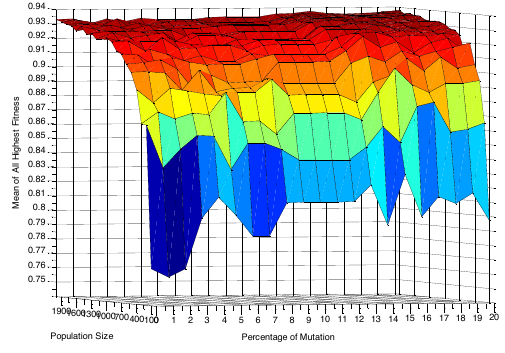
Figure 4.3.1 Mean Fitness of All Highest Fitness